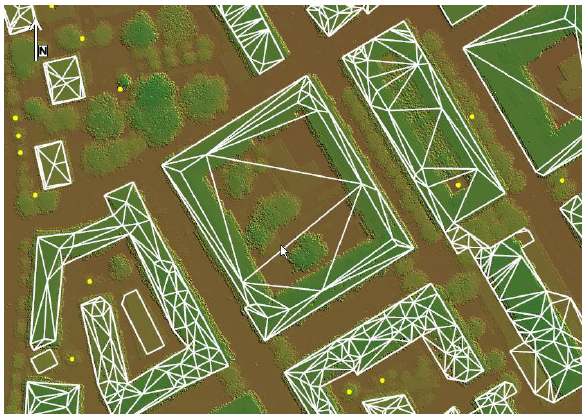
Figure 14. Complex building with interior